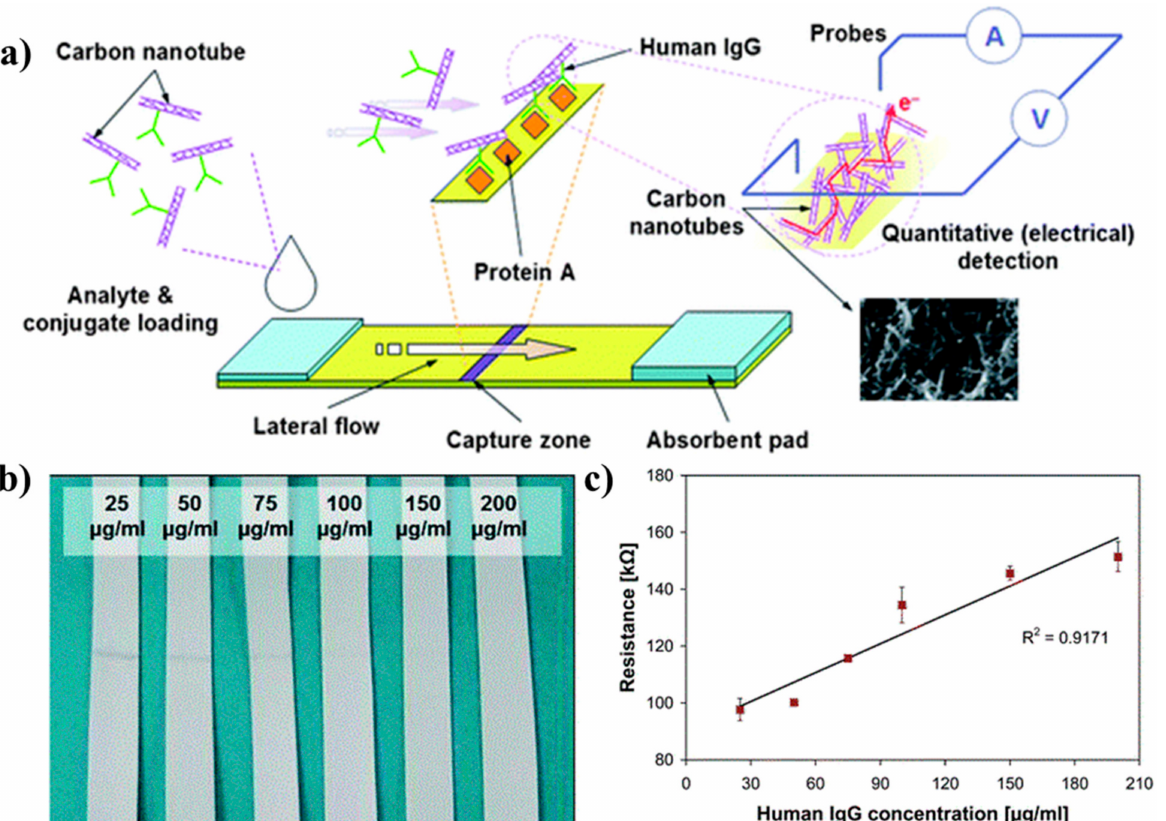
Figure 13. ( a ) Schematics of the quantitative lateral flow immunoassay using CNTs as label. ( b ) The lateral flow immunosensor (7 mm width) with varying concentrations of HIgG. ( c ) The plot of the electrical resistance at the capture zones vs. HIgG concentration. Reproduced with permission from reference [68]. Copyright © 2020 Royal Society of